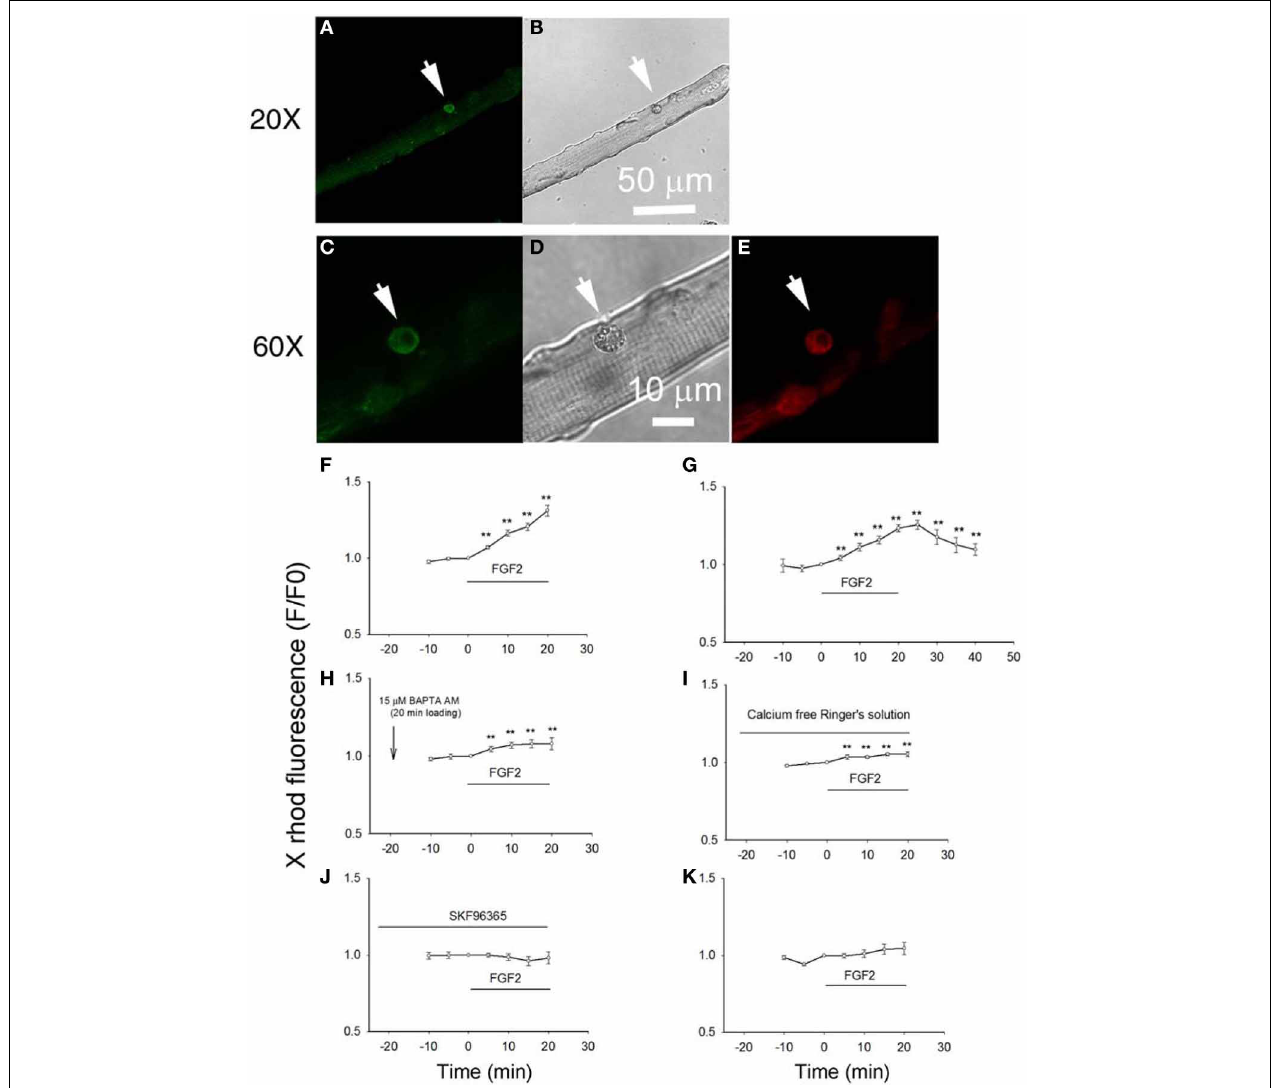
FIGURE 4 | Studying the effects of FGF2 on cellular calcium in satellite cells associated with host FDB fibers. Muscle cultures pre-stained with anti-CD34-FITC to identify satellite cells (A,C) were then loaded with calcium indicator X rhod-1 AM (E) . Transmitted light images are shown in (B,D) . Application of FGF2 at 2ng/ml to the culture triggered a rise of calcium in the satellite cell in the confocal image plane ( F ; 9 satellite cells from 2 mice). Rinse with Ringer’s solution without FGF2 reverses the rise in cell calcium